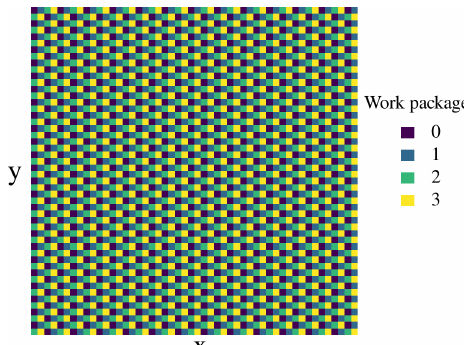
Figure 3. A round-robin distribution of grid elements into four work packages for the two-dimensional 50 × 50 grid of the SimDol2D scenario. Thereby, the elements with high compute demands, corre- sponding to the passing reaction front, are automatically distributed over the available